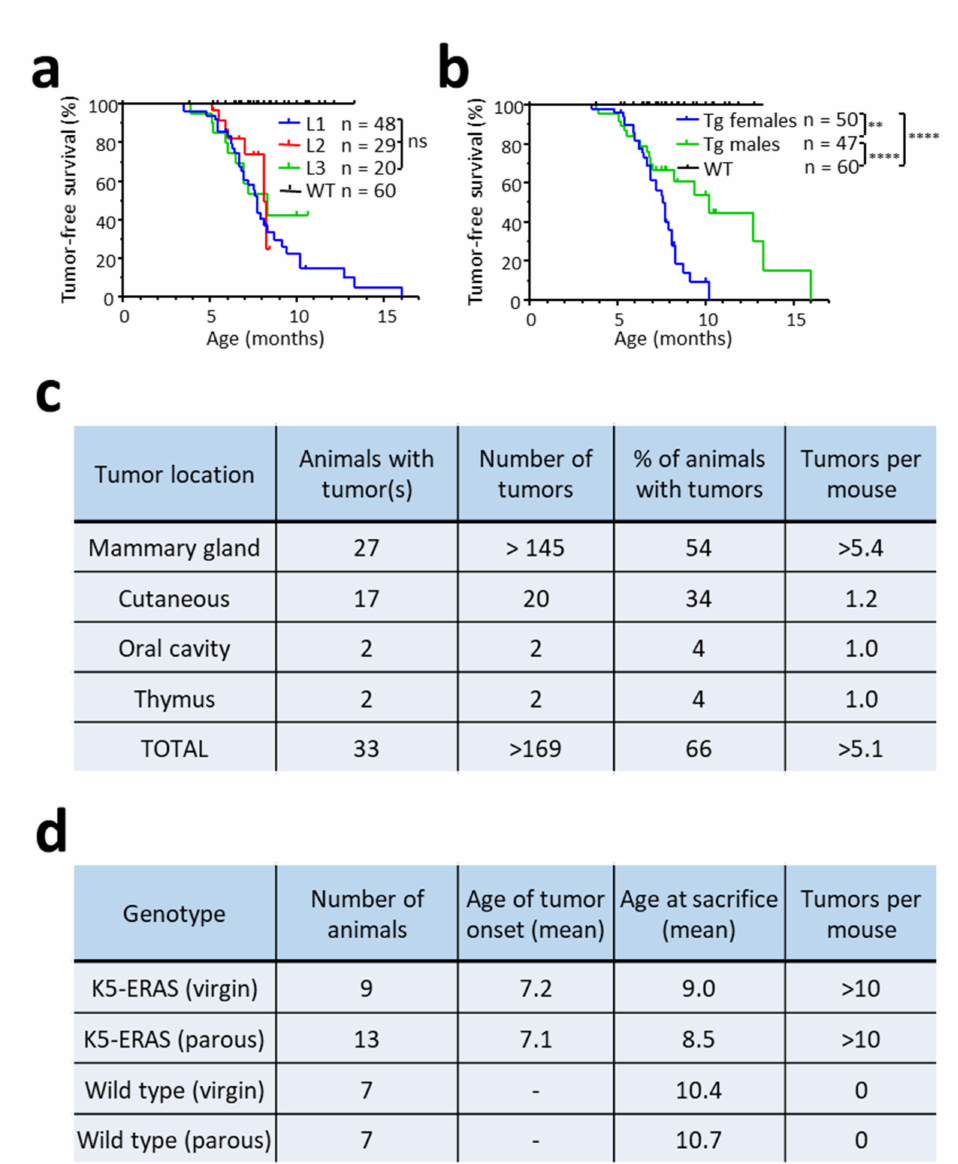
Figure 6. Spontaneous tumorigenesis in K5-ERAS transgenic mice. ( a ) Kaplan–Meier analysis of tumor-free survival in populations of wild type and transgenic mice from L1, L2 and L3 lines. This plot includes all the tumor types observed. The number of mice studied was 60 WT mice and 48, 29 and 20 transgenic mice form L1, L2 and L3 lines, respectively. The differences between transgenic lines are non-significant. ( b ) Tumor incidence in female and male K5-ERAS transgenic mice. ** p < 0.01; **** p < 0.0001. ( c ) Location of the tumors found in the group of female transgenic mice studied longitudinally. ( d ) Mammary tumorigenesis in multiparous and virgin K5-ERAS and WT females. Neither tumor onset nor multiplicity were affected by